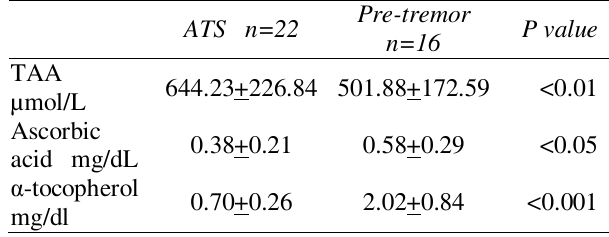
Table 8: Total antioxidant, ascorbic acid, and α -tocopherol level in anemia tremor